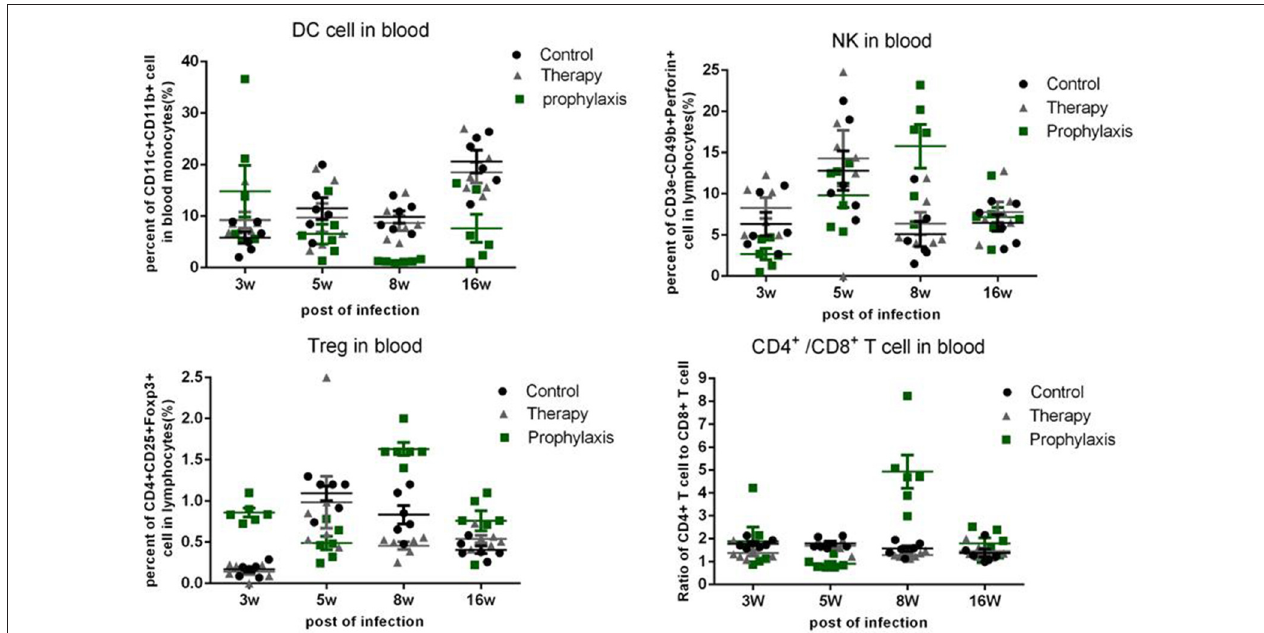
FIGURE 5 | Percentages of dendritic cells (DC), natural killer (NK) cells, and Treg cells, and the ratios of CD4 + /CD8 + T cells in the blood. The results are expressed as mean ± SEM, plotted using GraphPad Prism version 4.01 (GraphPad, San Diego, CA).